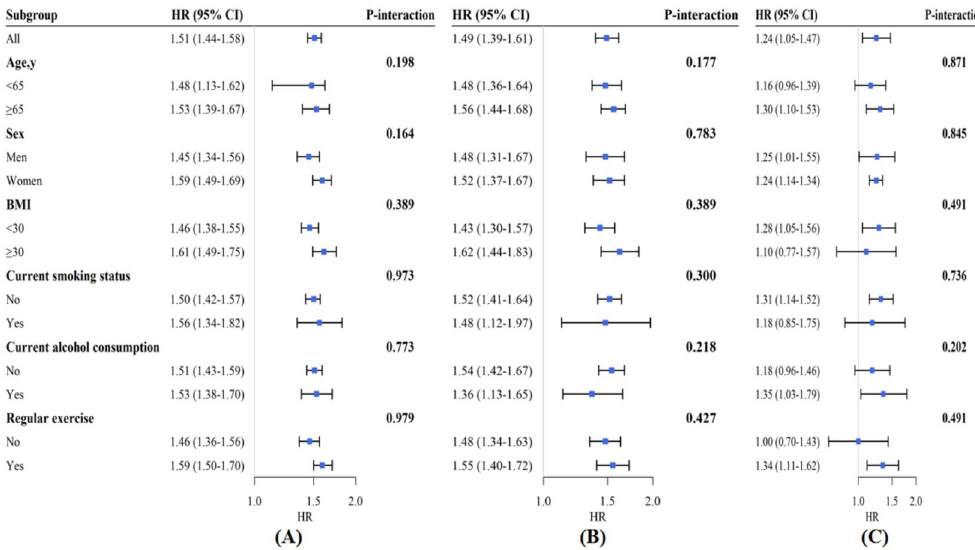
Figure 2. Subgroup analyses for the hazard ratio of all-cause ( A ), cardiovascular ( B ) and cancer mortality ( C ) for each 1 mg/L increase in cystatin C concentrations. Adjusted for age, sex, race, educational level, current smoking status, alcohol consumption, regular exercise, body mass index (BMI), household income, total cholesterol (TC) concentration, high-sensitivity C-reactive protein concentration, high density lipoprotein cholesterol (HDL-C) concentration, hemoglobin A1c (HbA1c) concentration, CES-D 8 score, hypertension, heart disease, stroke, cancer, diabetes, pulmonary disorders, psychiatric problems, and limitations in activities of daily living